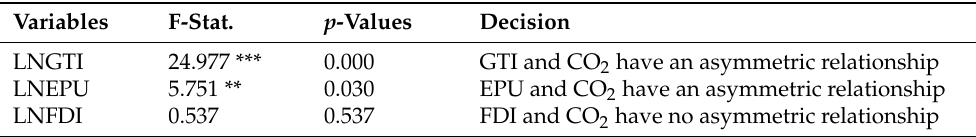
Multiplier for LNGI(+) Multiplier for LNGI(-) Asymmetry Plot (with C.I.) Figure 5. The dynamic multiplier for LNGTI.